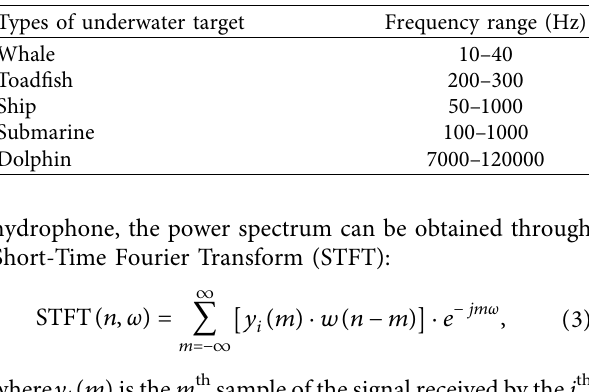
Figure 3: Orientation principle of the human auditory system. Table 1: Frequency range of acoustical signals generated by some typical underwater